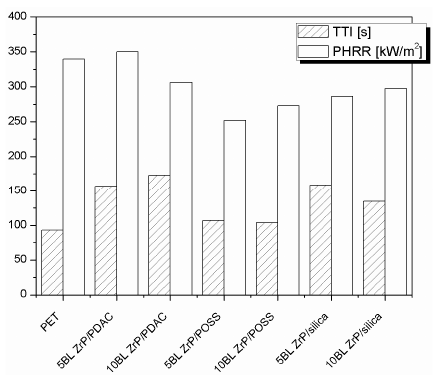
Figure 10. TTI and PHRR values of PET fabrics treated with 5 and 10 BL of ZrP coupled with PDAC, POSS or silica [25]. Data obtained by cone calorimetry under 35 kW/m 2 .